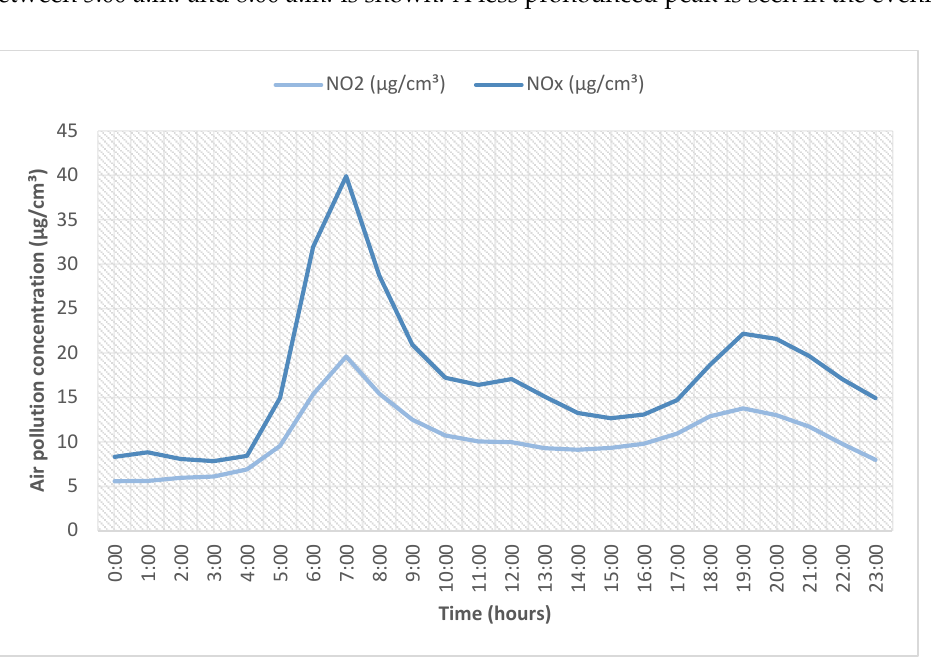
Figure 3. Diurnal trend of NO 2 and NO x in Adama City, averaged from 13 days with complete